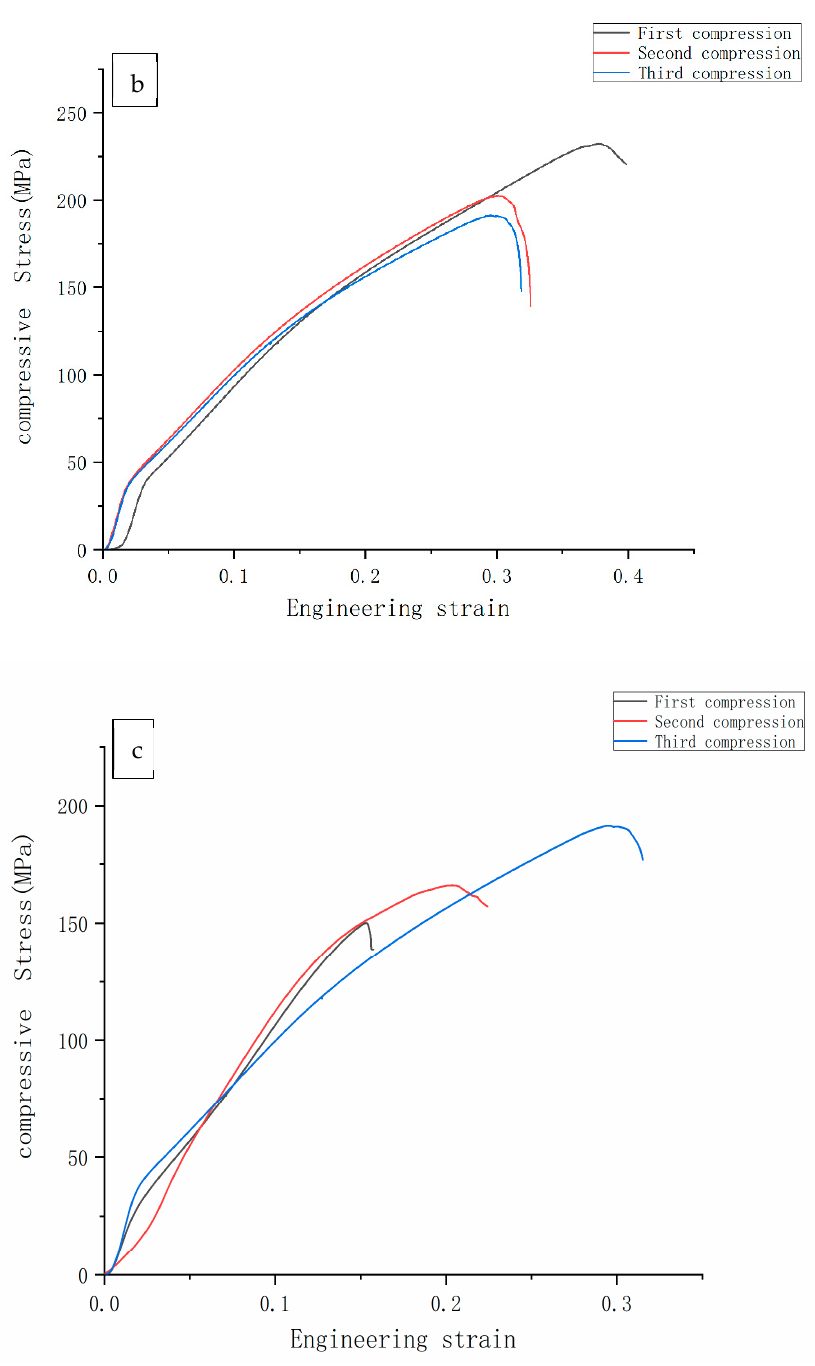
Figure 8. Maximum compressive stress: ( a ) Mg-0.5%Mn-2%Zn, ( b ) Mg-1%Mn-2%Zn, and ( c ) Mg- 1.5%Mn-2%Zn .